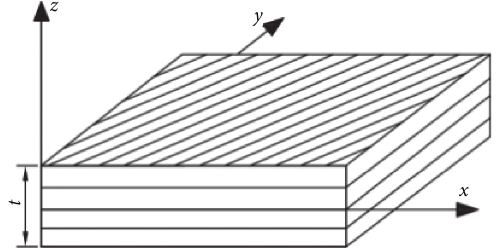
Figure 1: Schematic diagram of a composite laminated